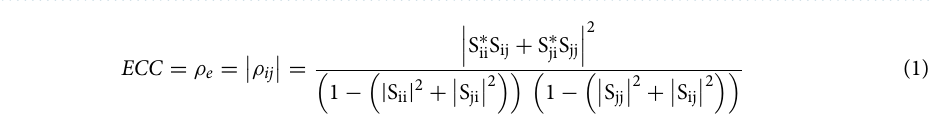
Figure 16. Transmission coefficients outcomes of the flexible MIMO antenna in bending configuration with R = 45 mm ( a ) S 21 , ( b ) S 31 and ( c ) S 41